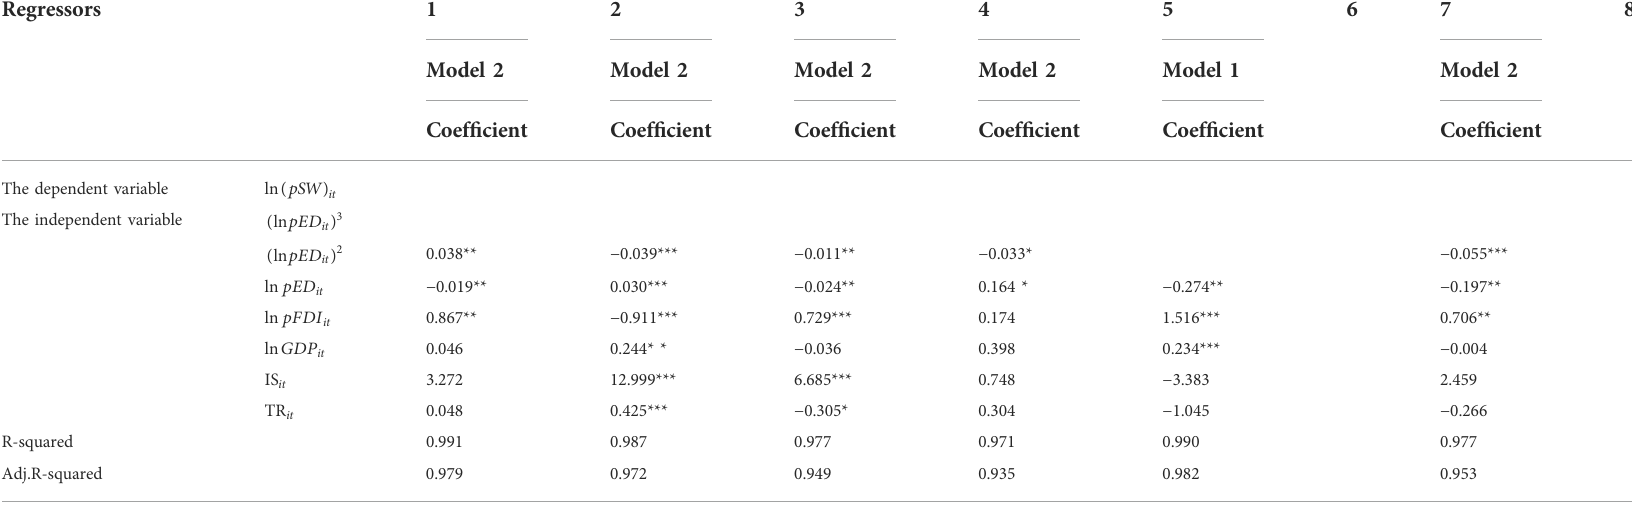
TABLE 12 The weighted DOLS results, China ’ s eight major economic regions, 2001 – 2017.